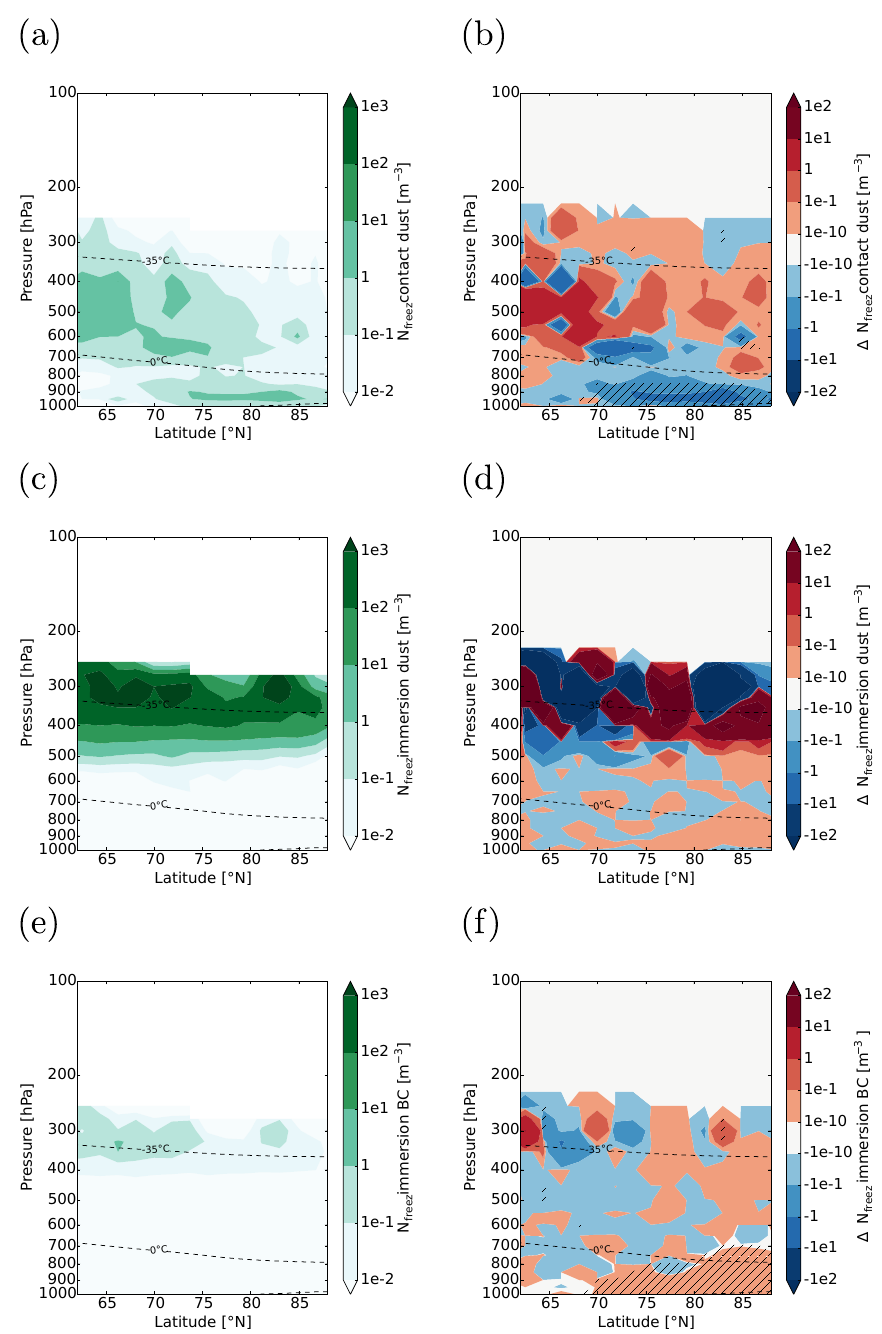
Figure 12. Number of cloud droplets that freeze heterogeneously per time step ( N freez ) in 2050: (a, b) contact freezing by dust, (c, d) immersion freezing by dust, (e, f) immersion freezing by black carbon in late summer (July–August). On the left side, absolute values for 2050 (reference) are shown. On the right side, the difference between a simulation with enhanced ship emissions and the reference simulation is displayed (difference between arctic_2050_shipping and arctic_2050). Note that the scale is logarithmic and that the lowest bin had to be decreased to 10 − 10 to display statistically significant increases in immersion freezing by BC. Hatched areas are significant at the 95% confidence level. The dashed lines show the 0 and the − 35 ◦ C